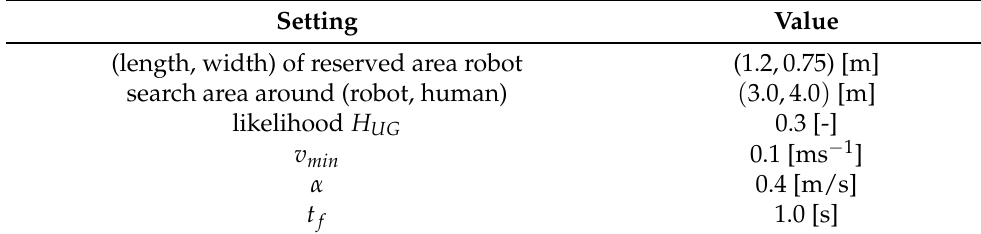
Figure 3. Overview of the prototype Ropod-platform as applied in this work in its target environment. Some of its relevant components are indicated. Table 2. Settings applied within the